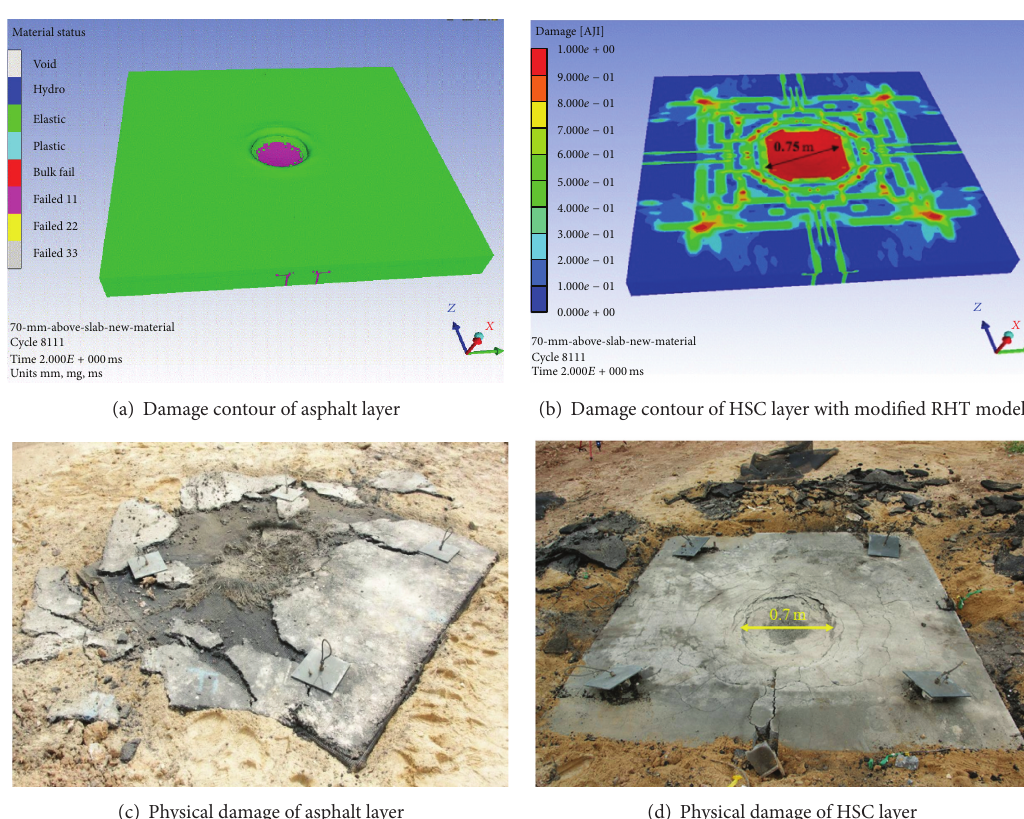
Figure 12: Damage pattern of multilayer concrete slab after blast loading.